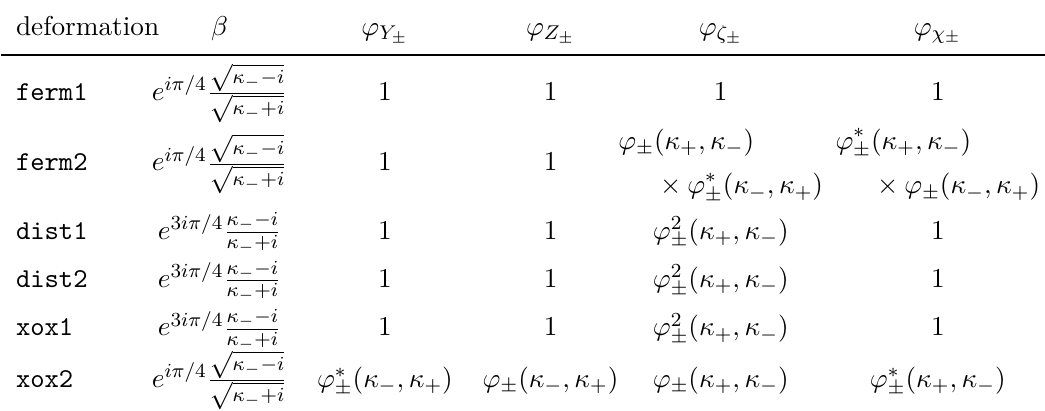
Table 2 : Values for the phases β , ϕ to compensate for possible basis differences of the creation and annihilation operators. As a result, the T matrices of all six cases take the same form; it is given in section 3.2. The common factor ϕ